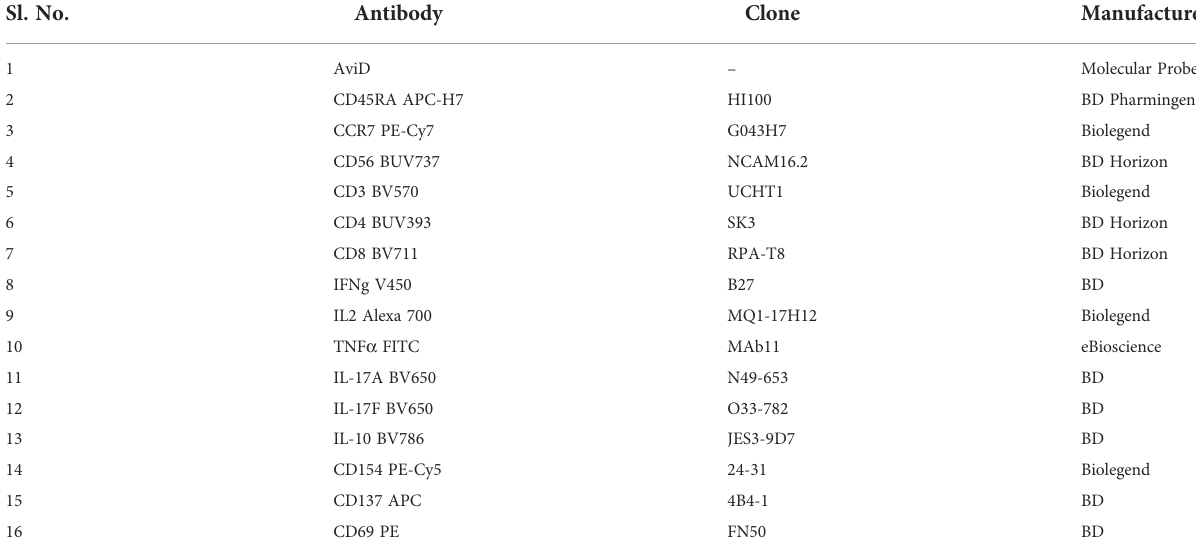
TABLE 3 Antibody panel to track SARS-CoV2 speci fi c T cell responses. Sl.